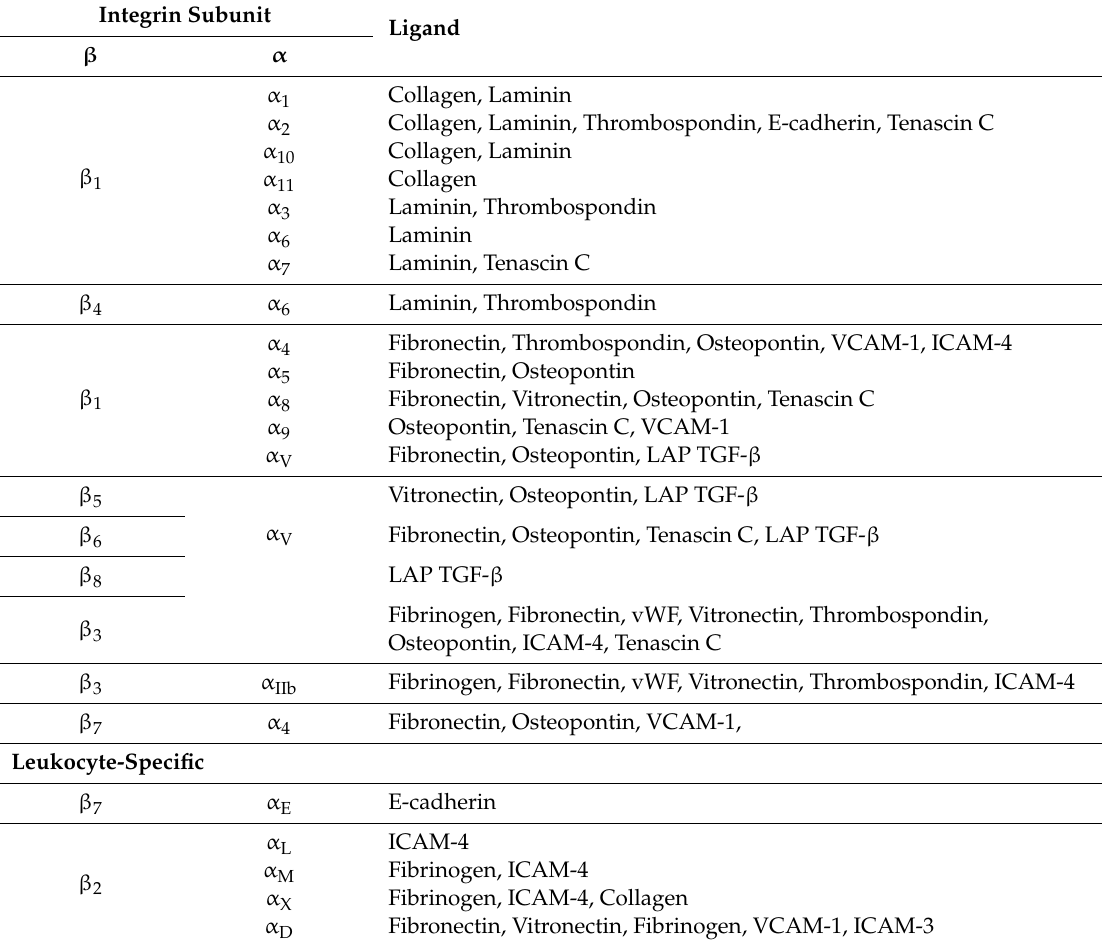
Table 5. Integrin subunit pairing and binding ligands [76,77,82–84]. VCAM: vascular cell adhesion molecule, ICAM:intercellularadhesionmolecule, LAP:latency-associatedpeptide, TGF- β : transforming growth factor beta, vWF: von Willebrand